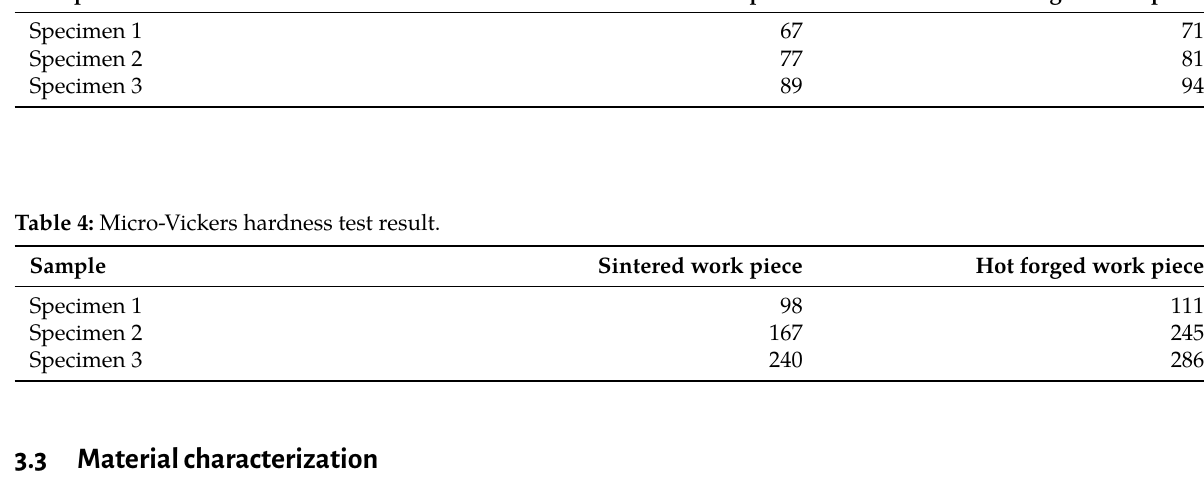
Table 3: Rockwell hardness (B-scale) test result. Sample